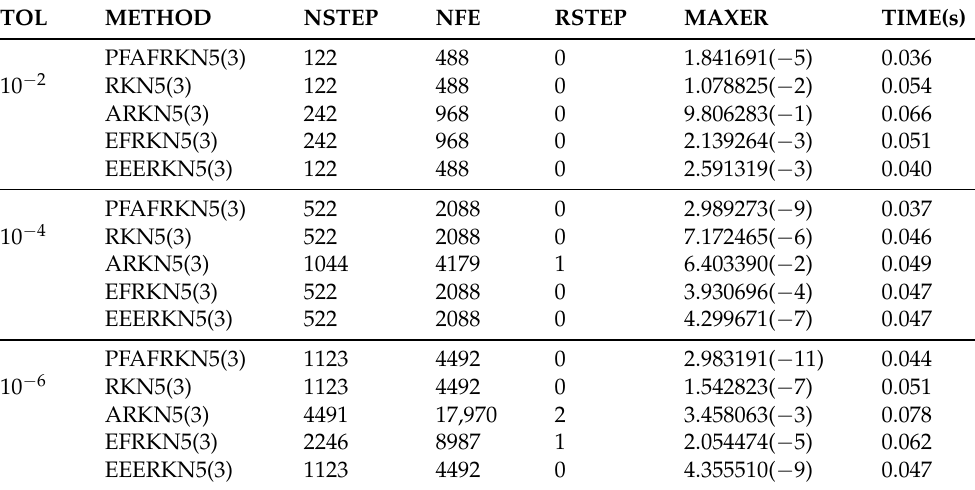
Table 2. Numerical data corresponding to Problem